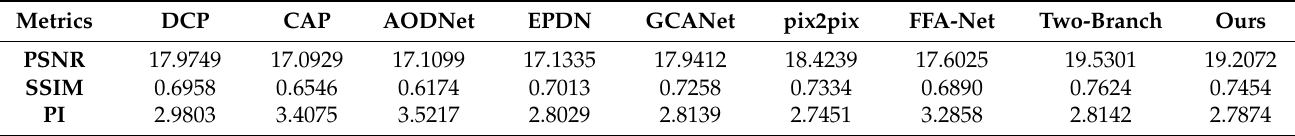
Table 2. Quantitative results on the NTIRE dehazing challenge